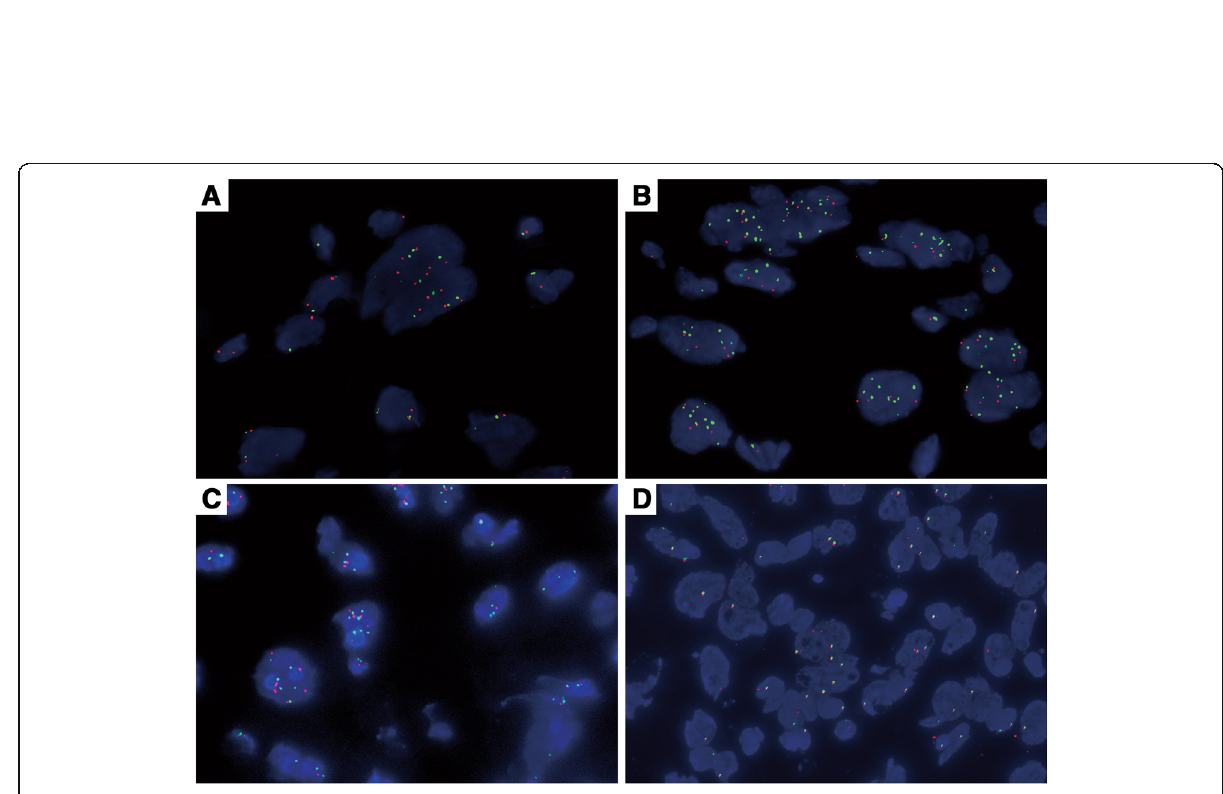
Fig. 3 FISH examination of met gene status by MET (red)/CEP 7(green). Chromosome 7 polysomy, rather than MET amplification, was found in FNCLCC Grade 2 cases ( a ), Grade 3 cases ( b ), and epithelioid variant ( c ). Lower FNCLCC grade cases are usually negative for either MET amplification or chromosome 7 polysomy ( d )